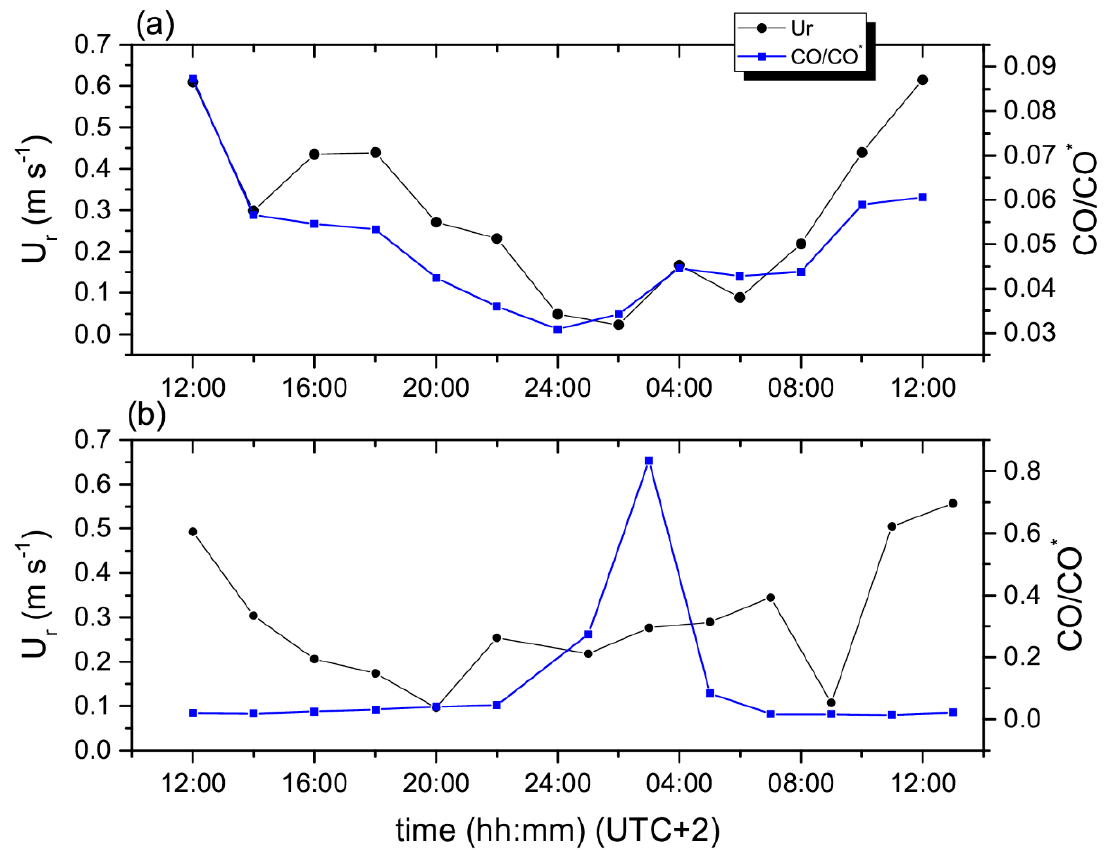
Figure 9. Diurnal pattern of the thermal circulation velocity and of normalized CO concentrations in ( a ) Marconi St. and in ( b ) Laura Bassi St. during the summer intensive thermographic campaign.